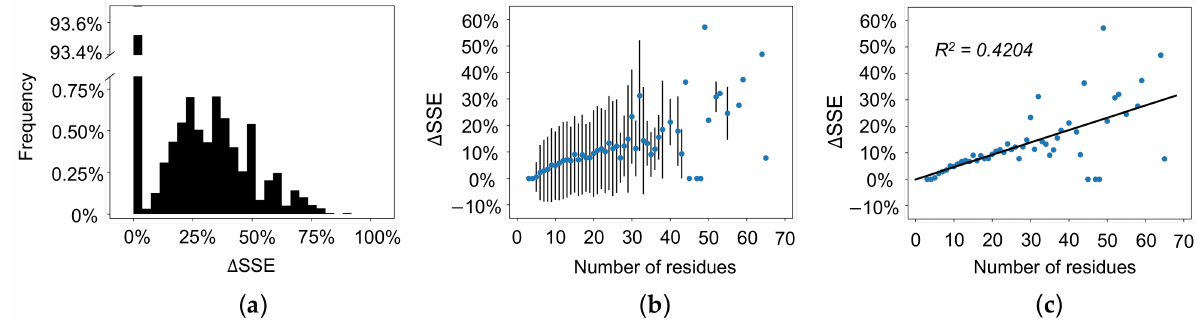
Figure 4. Percent change in secondary structure content ( ∆ SSE) from experimentally determined structures to AlphaFold predicted structures. ( a ) ∆ SSE of all loop regions. Greater than 90% of loops have a ∆ SSE of 0%. ( b ) Average ∆ SSE as a function of the number of residues in a loop with standard error bars. ( c ) Average ∆ SSE as a function of the number of residues in a loop with linear regression (R 2 = 0.4204). ∆ SSE increases as the number of residues in the loop regions